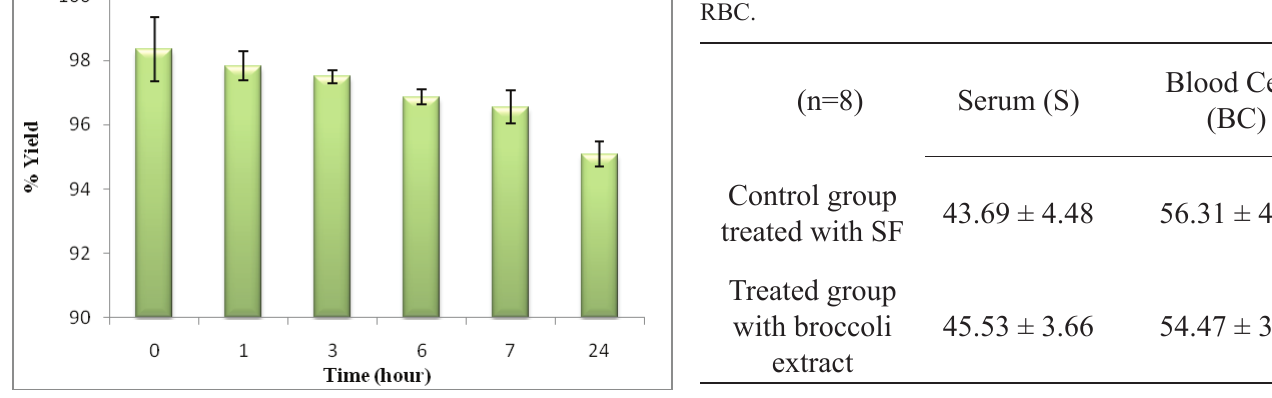
FIGuRE 4 - Stability of 99m Tc-GH.